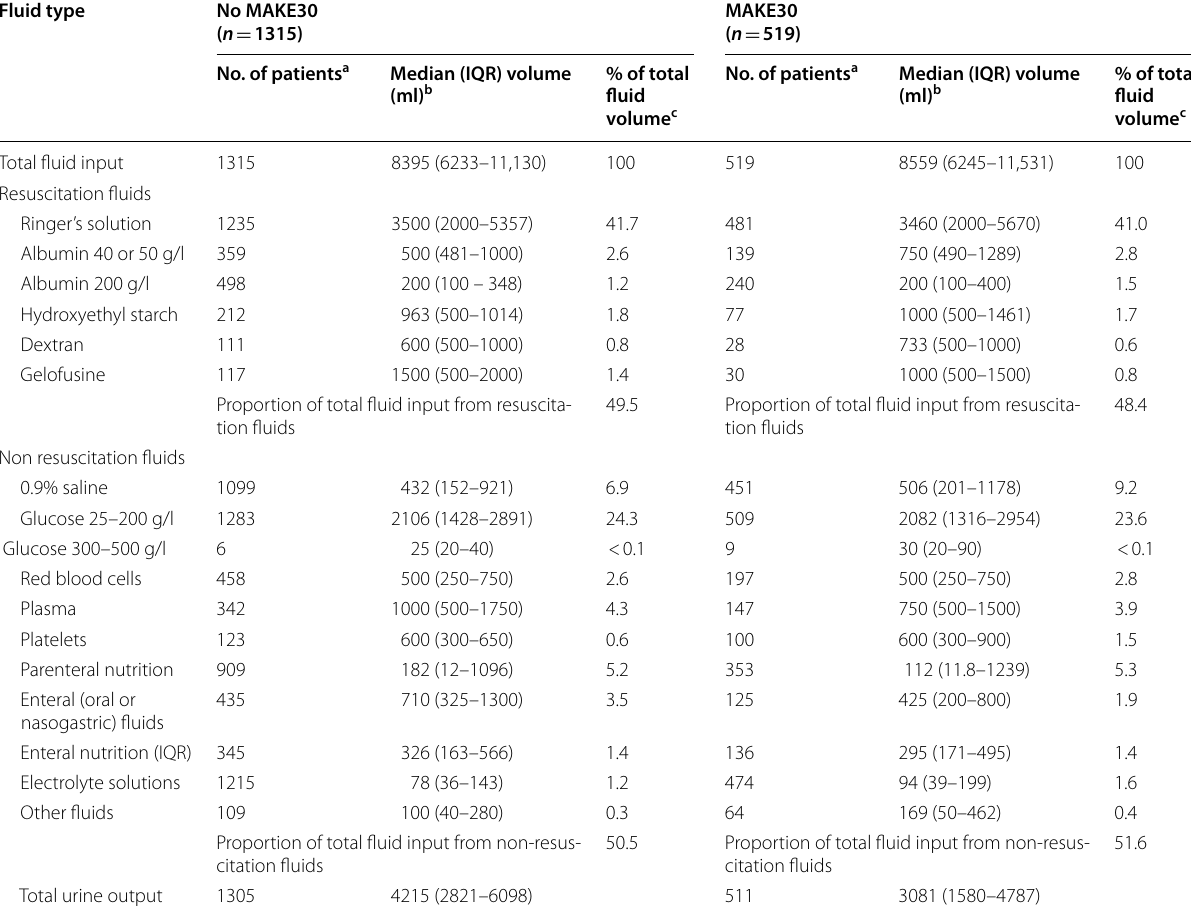
Table 4 Type and volume of administered fluids and urine output during the first 2 days in